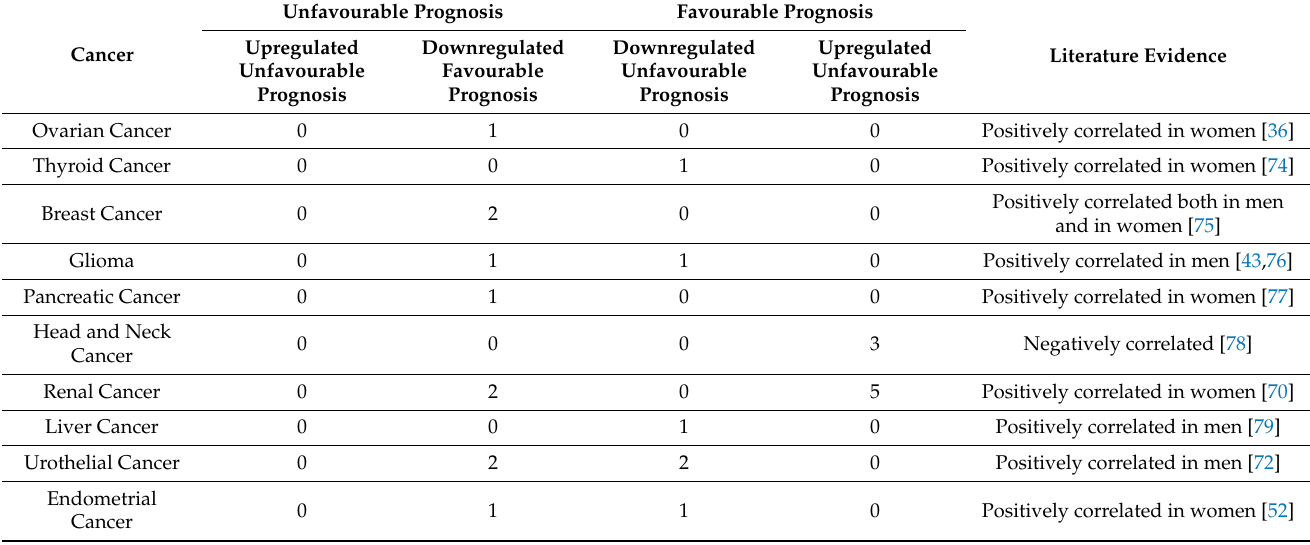
Table 7. Prognosis score associated with each cancer. Unfavorable or favorable prognosis was assessed according to orange or blue edges, respectively. Upregulated or downregulated genes were described according to their log2FC. A bibliographic search was performed to assess previous correlations of each cancer type with gender.